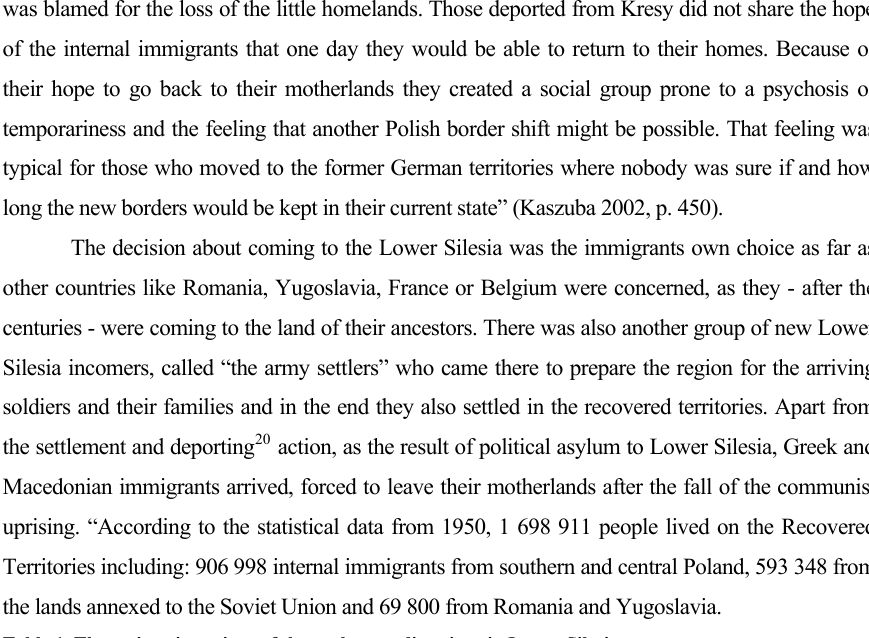
Table 1. The main orientations of the settlement directions in Lower